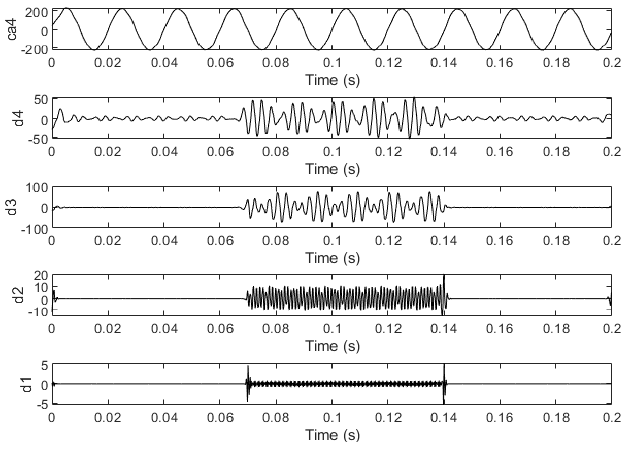
Figure 24. Oscillatory transient.